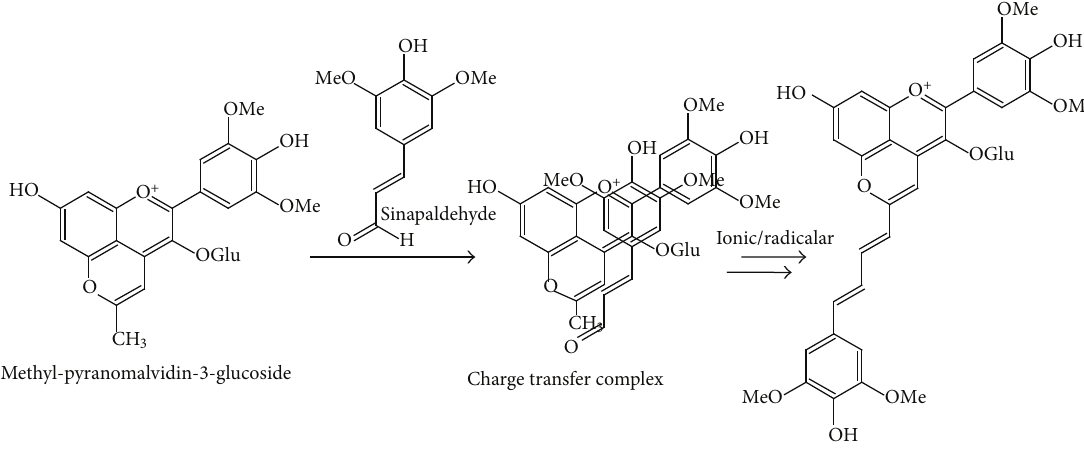
F 11: Proposed mechanism for the formation of pyranomalvidin-butadienylidene-sinapyl from the reaction of methylpyranomalvidin- 3- O -glucoside with sinapaldehyde